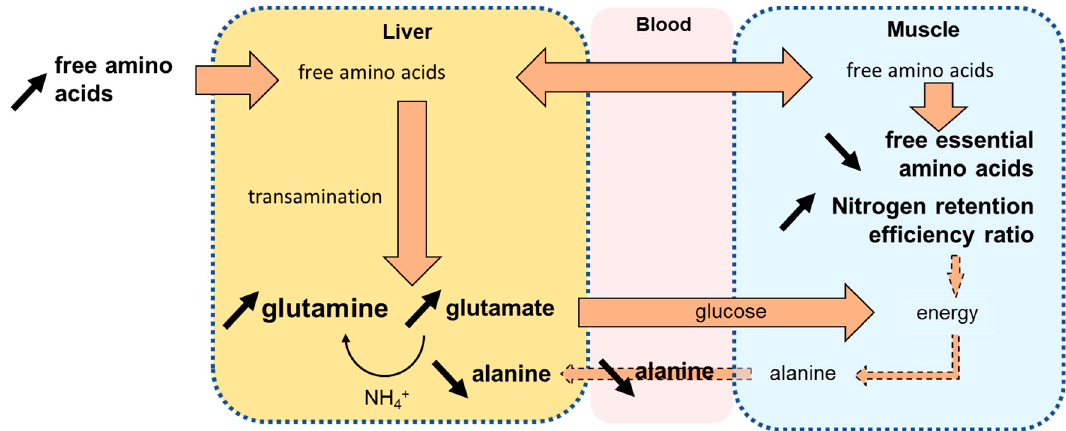
Figure 5. Simplified diagram of the relationships between liver, blood and muscle metabolites involved in Cahill cycle and protein synthesis, integrating hypotheses based on the present experiment. The increase of free amino acids from INS diet would rise the glutamate and glutamine contents in liver to supply energy to muscle. In muscle, the free amino acids are rather used for protein synthesis than for energetic purpose. The alanine content from Cahill cycle would consequently decrease.